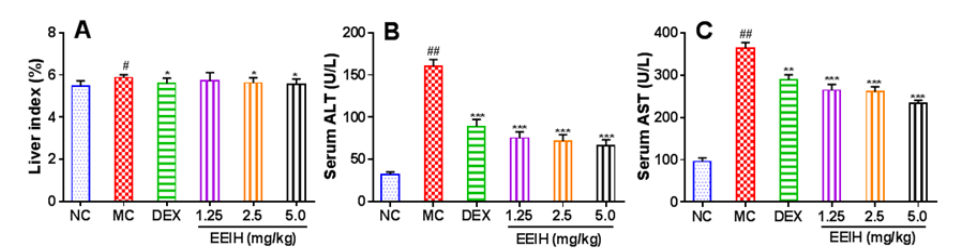
Figure 3. Effects of EEIH on the liver index ( A ), serum alanine aminotransferase (ALT, B ) and aspartate aminotransferase (AST, C ) levels in LPS-induced acute liver injury mice. The values are presented as the means ± SD ( n = 5). P values were determined by ANOVA and a Tukey post-hoc test. Significant differences compared to the normal control group (NC) are designated as # p < 0.01 and ## p < 0.001, those compared to the model control group (MC) as * p < 0.05, ** p < 0.01, and *** p < 0.001. DEX: dexamethasone (positive control).